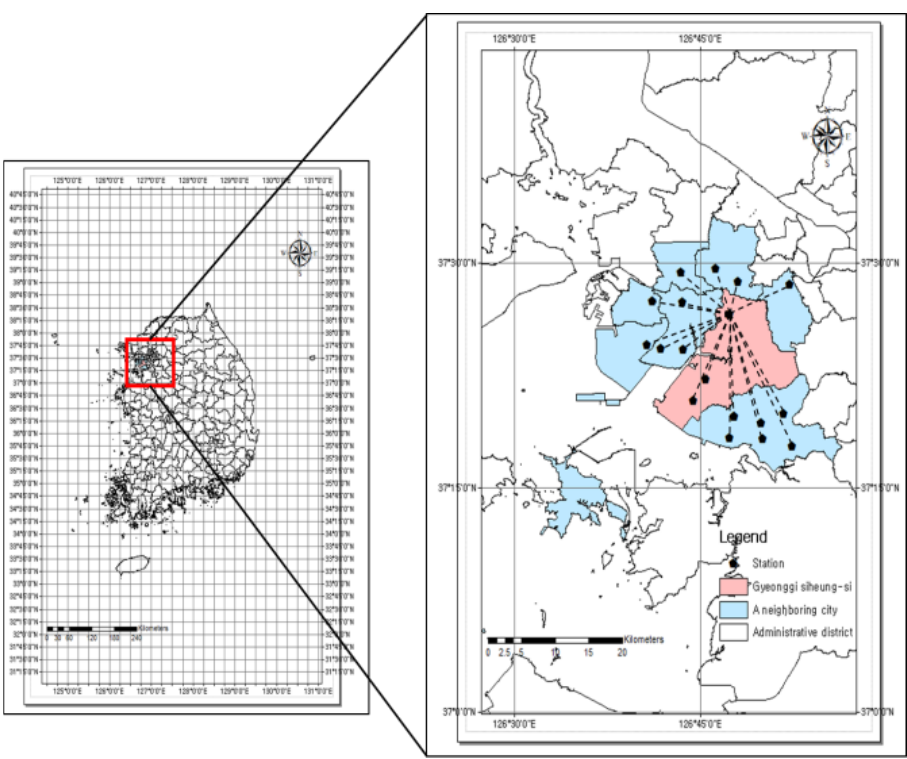
Figure 1. Study area. Black pentagonal (right panel) points are air pollutant monitoring stations in Korea (data source: Korea Environment Corporation).